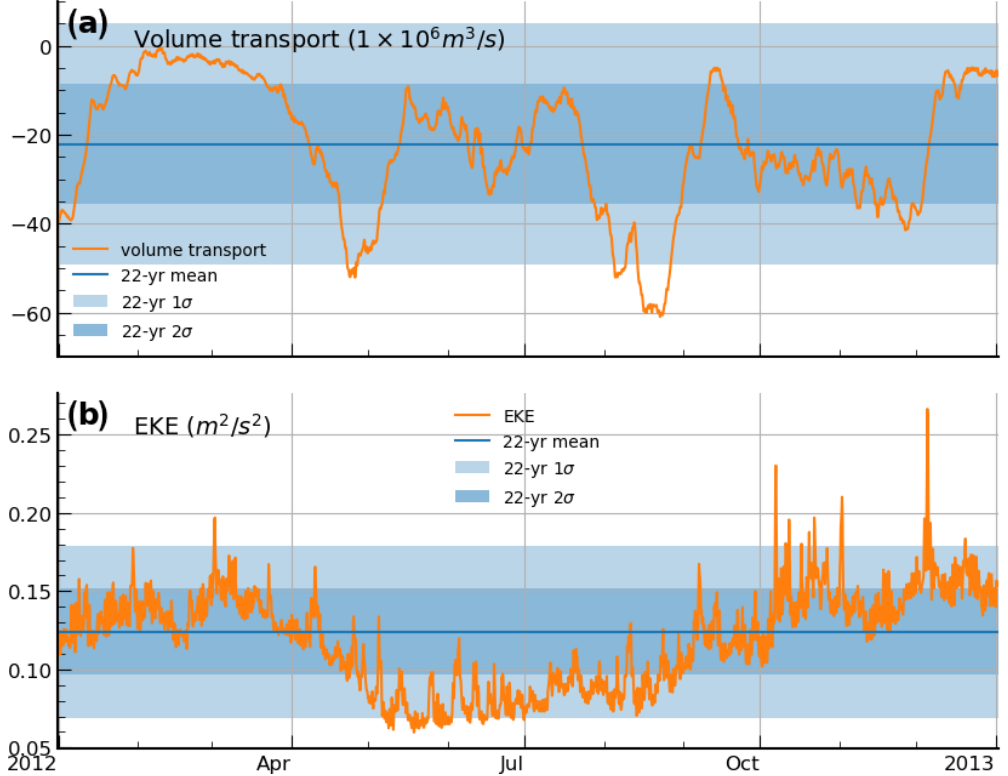
Figure A1. Volume transport and EKE conditions of the 1-year free-running simulation. (a) Integrated volume transport through a transect at ∼ 28 ◦ S (orange line). The blue line is the mean volume transport from the 1994–2016 long-running simulation, while the darker and lighter shaded regions show ± 1 and ± 2 standard deviations. Likewise, (b) shows the spatial-mean EKE over the whole domain (orange line). The blue line and shaded regions showing the mean, ± 1, and ± 2 standard deviations, respectively, in EKE for the long-running 1994–2016